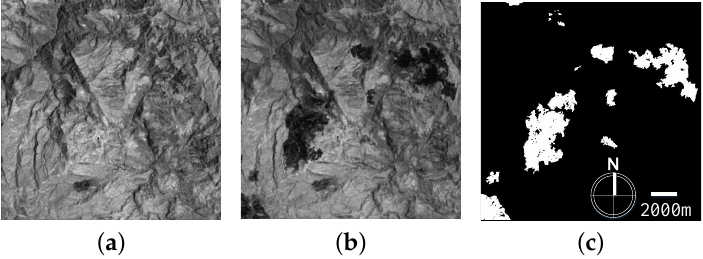
Figure 8. The Mexico dataset: ( a ) the optical gray image acquired in April 2000, ( b ) the optical gray image acquired in May 2002, and ( c ) the reference image.